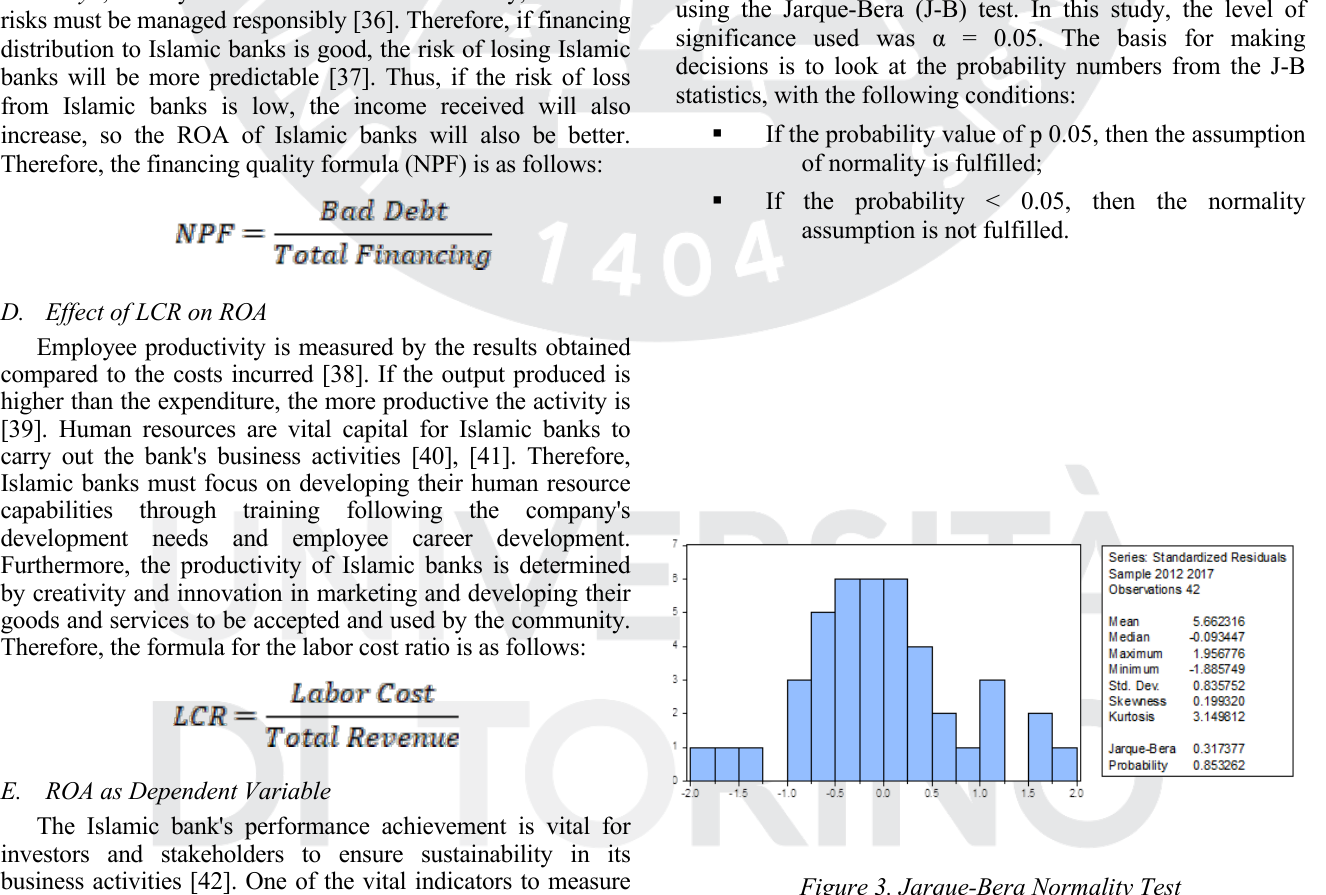
Figure 3. Jarque-Bera Normality Test Source: Results of the Eviews 9